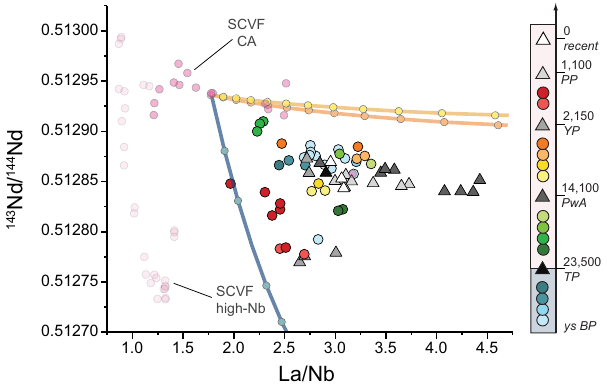
Figure 13: 143 Nd/ 144 Nd vs. La/Nb for Popocatépetl and Ventorrillo samples, with calc-alkaline and high- Nb suites from the SCVF [Straub et al. 2015] for com- parison. AFC model calculated using calc-alkaline SCVF sample CH-09-2 with same assimilants and pa- rameters as in Figure 11A–C. See text for